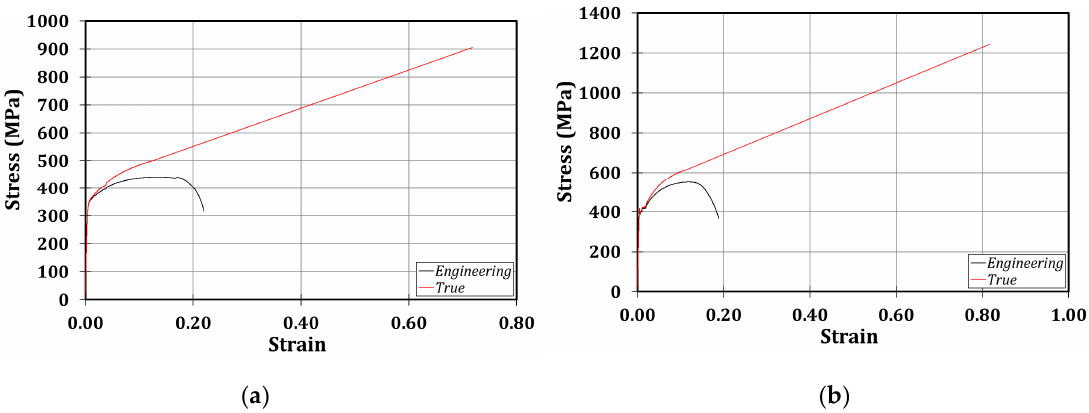
Figure 3. Results of the coupon tests: stress-strain laws referred to the column, f y = 348.2 MPa ( a ); stress-strain laws referred to the beam, f y = 391.9 MPa ( b ).